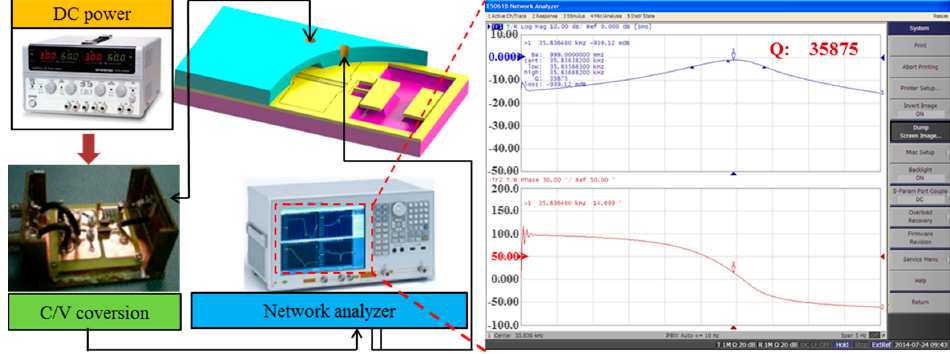
Figure 11. Open loop experimental set-up for the Q test of the resonator. Network analyzer is the main electrical equipment of open loop test.